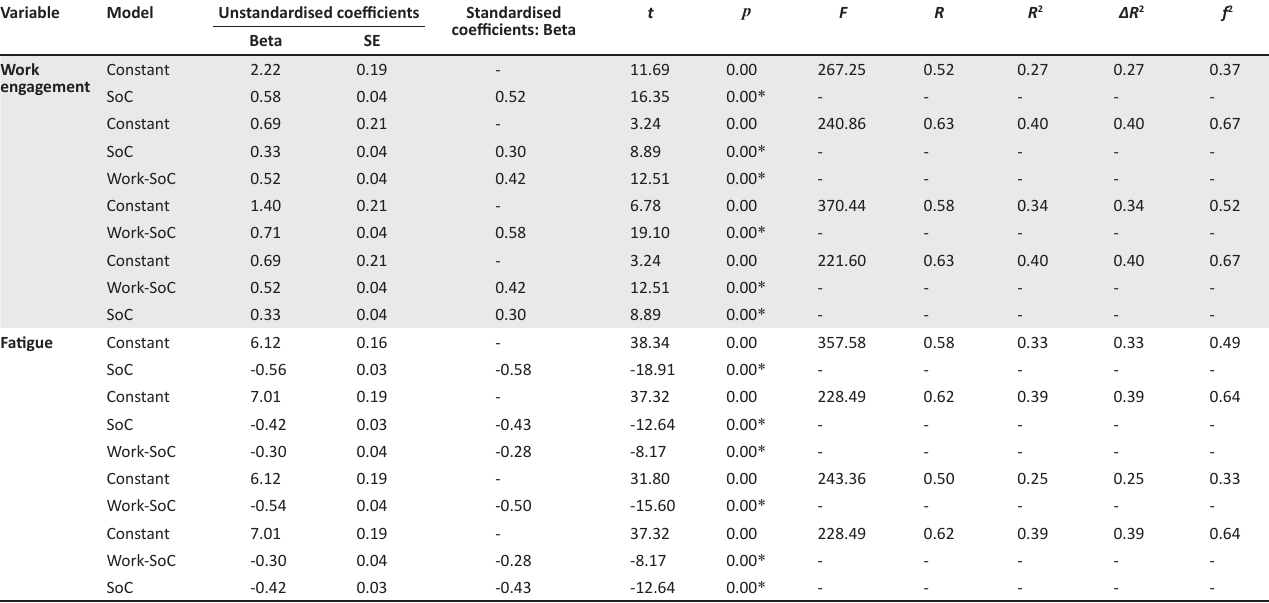
TABLE 4: Regression analyses of Work-SoC and SoC with work engagement and fatigue as dependent variables. Variable Model